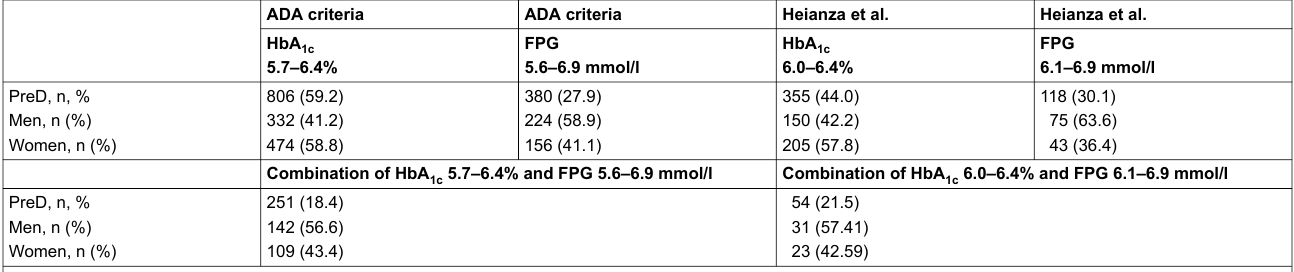
Table 3: Prevalence of impaired glucose metabolism, PreD and T2DM according to the ADA criteria and based on a combination of narrowing cut-offs as published by Heianza et al. [17]. ADA criteria ADA criteria Heianza et al. Heianza et